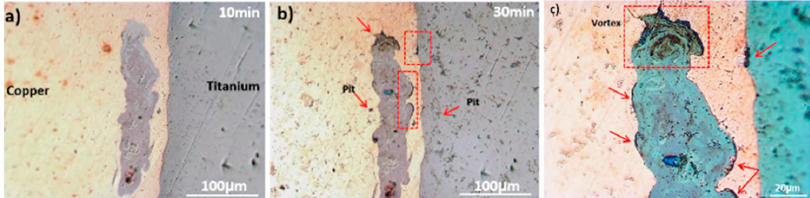
Figure 16. Optical micrograph of the galvanic corrosion initiation sites on welded interface and LMZ after immersion in 3.5 wt.% NaCl corrosive solution with different immersion times, ( a ) 10 min, and ( b ) 30 min. ( c ) is the greater magnification of LMZ in ( b ).